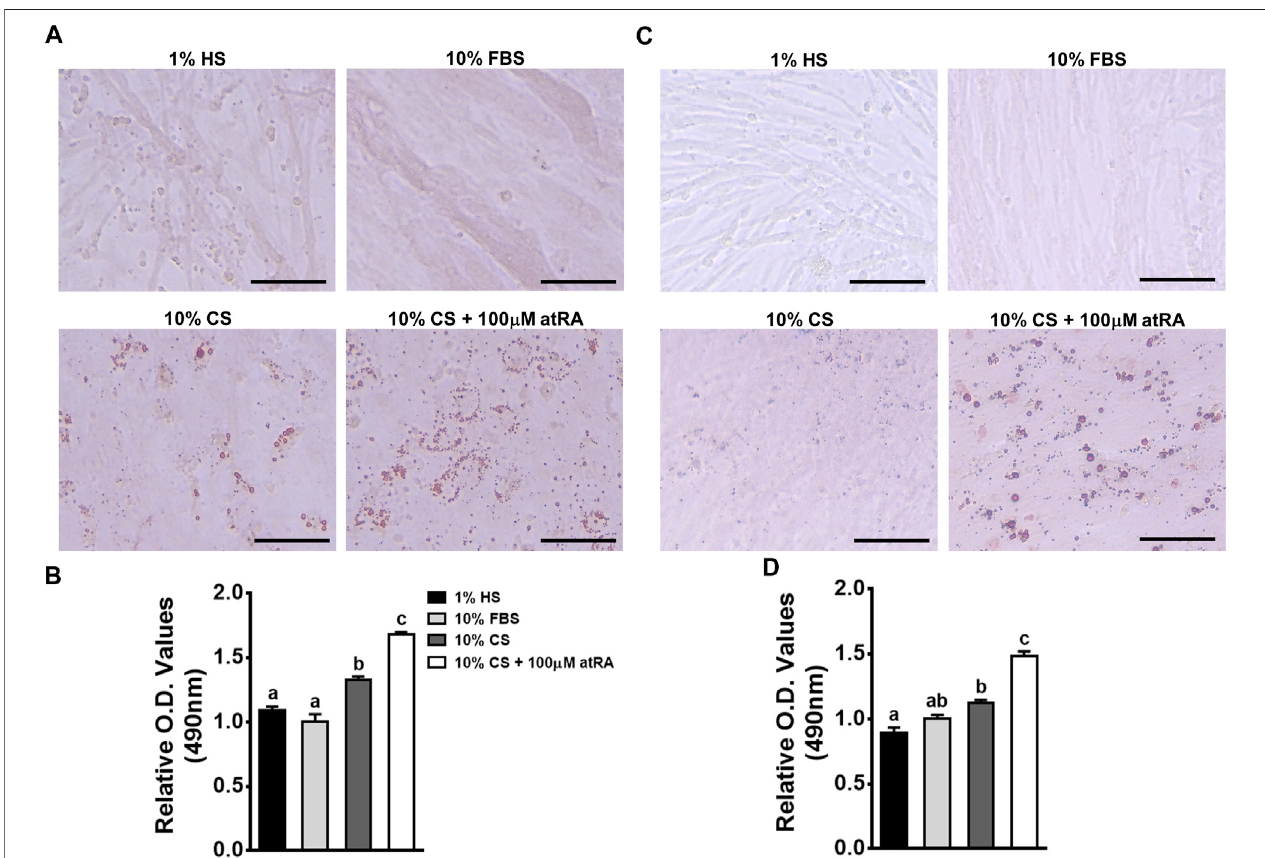
FIGURE 3 | Adipogenic differentiation of avian primary myoblasts by atRA. Primary myoblasts were isolated from breast muscle tissues of quail (A and B) and chicken (C and D) embryos at embryonic day 12 and 13, respectively. The cells were grown in four different media for 48 h: 1% HS as a standard myogenic medium, 10% FBS as a standard growth medium, 10% CS as a control medium, and 10% CS with 100 μ M of atRA as an adipogenic medium, and then assessed for lipid accumulation.TheORO-stainedcellswerevisualizedunderamicroscope (A and C) andquanti fi edbyarelativeamountofOROpercellwhichwasnormalizedbya group of 10% FBS (B and D) . Scale bar: 100 μ m. All data were shown as mean ± SEM ( n = 8 from 4 independent experiments). One-way ANOVA followed by Tukey ’ s multiple comparison test was used for statistical analysis by the GraphPad PRISM program and statements of signi fi cance noted by (A-C) are based on testing at p < 0.05.